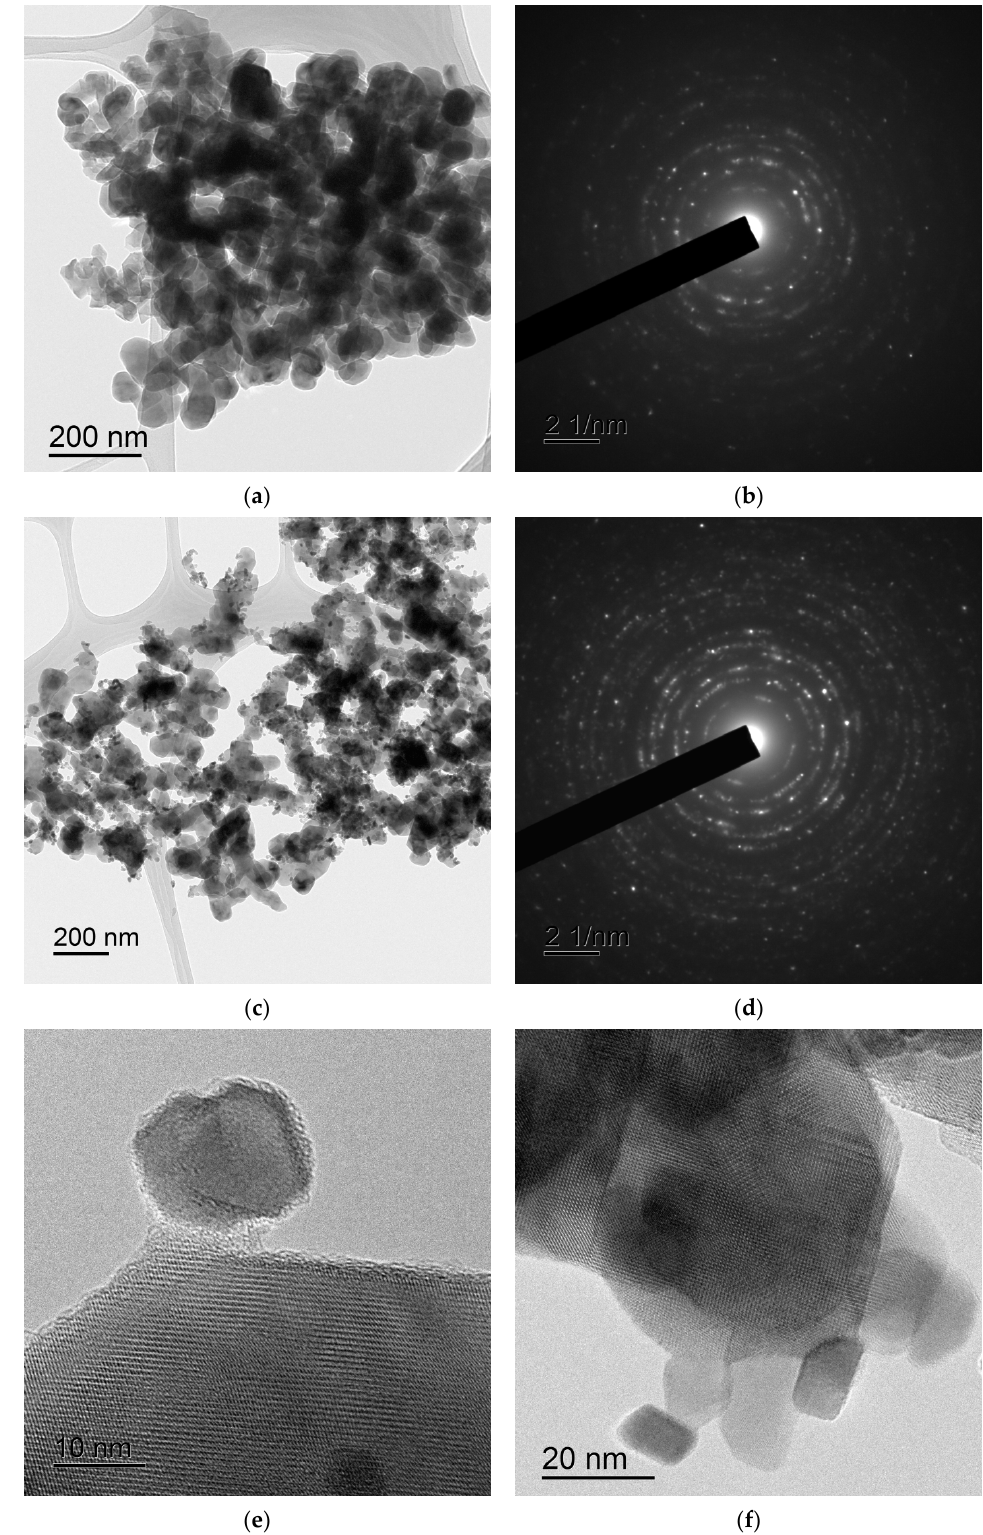
Figure 5. TEM images of the powders Na 0.5 Zr 2 (PO 4 ) 2.5 (XO 4 ) 0.5 : X = Mo ( a , b , e ), X = W ( c , d , f ).